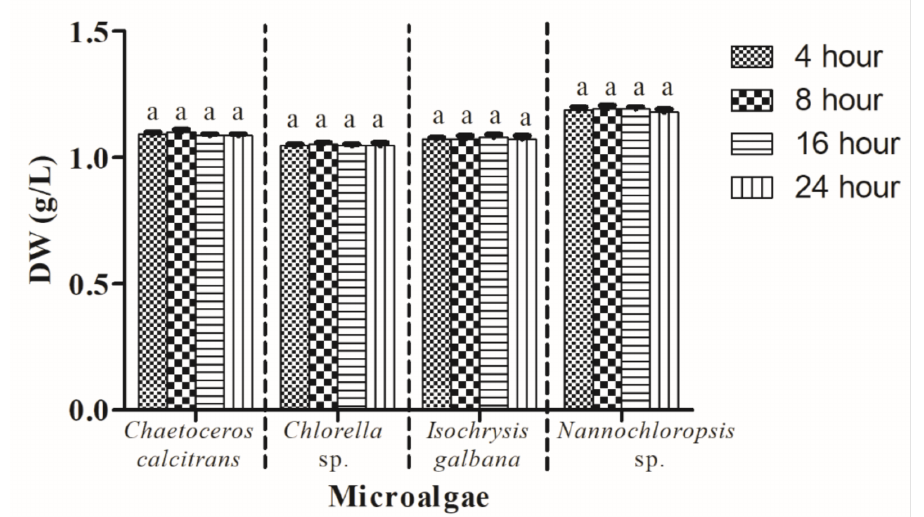
Figure 8. Dry weight of four different marine microalgae subjected to different drying periods at 100 ◦ C. The other parameters remained constant (with washing process; GF/A; pretreatment of GMF at 450 ◦ C for 2 h; 0.05 M ammonium formate; 1:2 culture: washing agent ratio; two washing cycles). Different letters for the respective microalgae indicate statistically significant differences ( p < 0.05) in terms of dry weight among different drying periods. DW, dry weight. Data are expressed as mean ± standard error (n =